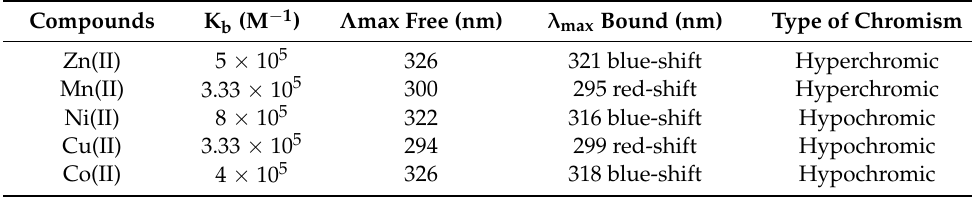
Table 3. Absorption spectral titrations data.